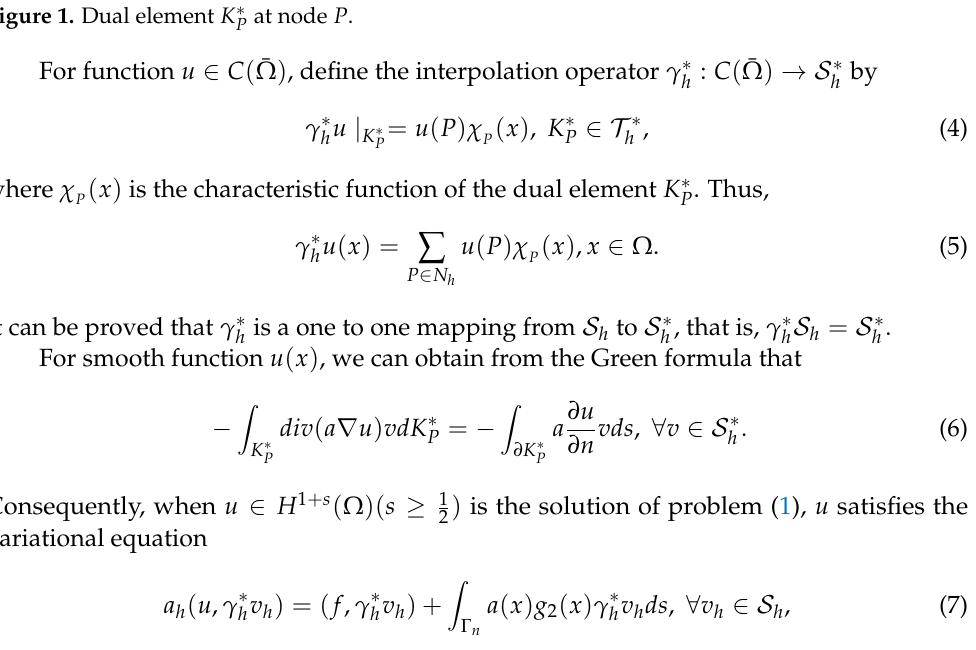
Figure 1. Dual element K ∗